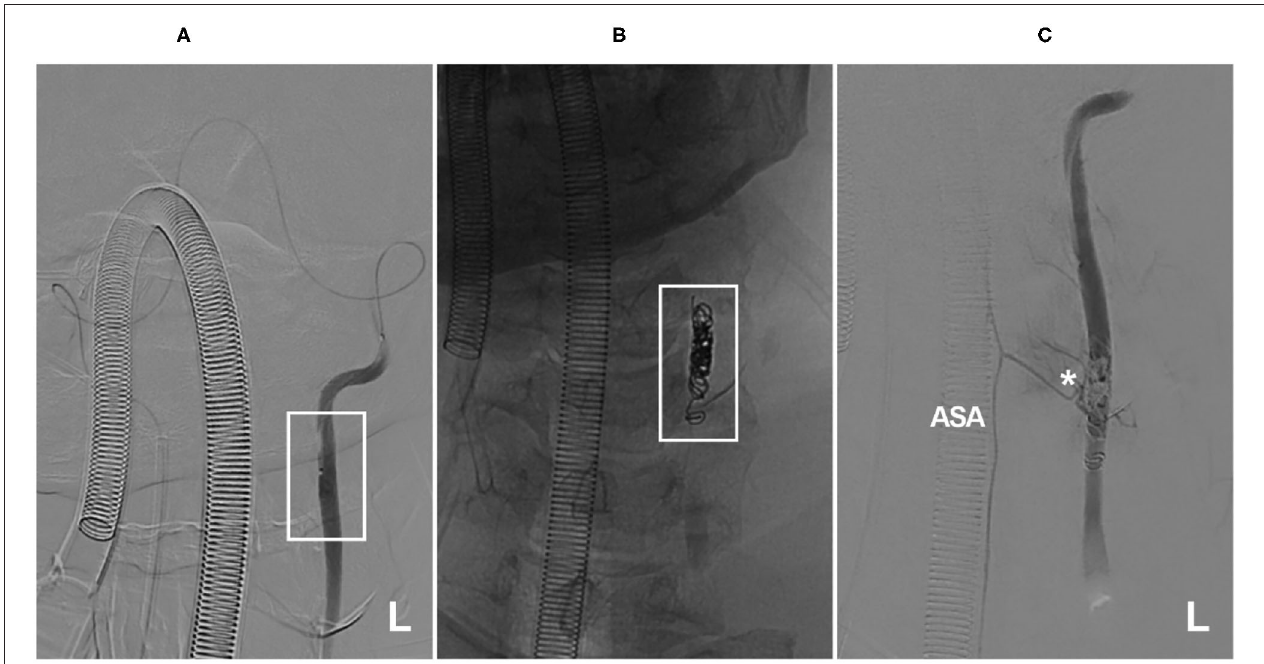
FIGURE 8 | Insufficiency of the artery of cervical enlargement after VA occlusion. (A) A microcatheter angiogram showed that the microcatheter reached the left VA (frame) from the right to perform VA occlusion, and no segmental artery was observed. (B) X-ray film showed left VA occlusion by coiling (frame). (C) A microcatheter angiogram showed that the coils occluded the origin of the artery of cervical enlargement (asterisk). ASA, anterior spinal artery; L, left; VA, vertebral artery. The patient was a 56-year-old man. He suffered neck bleeding from the VA; thus, the VA was occluded. After the treatment, he had no new neurological deficits.